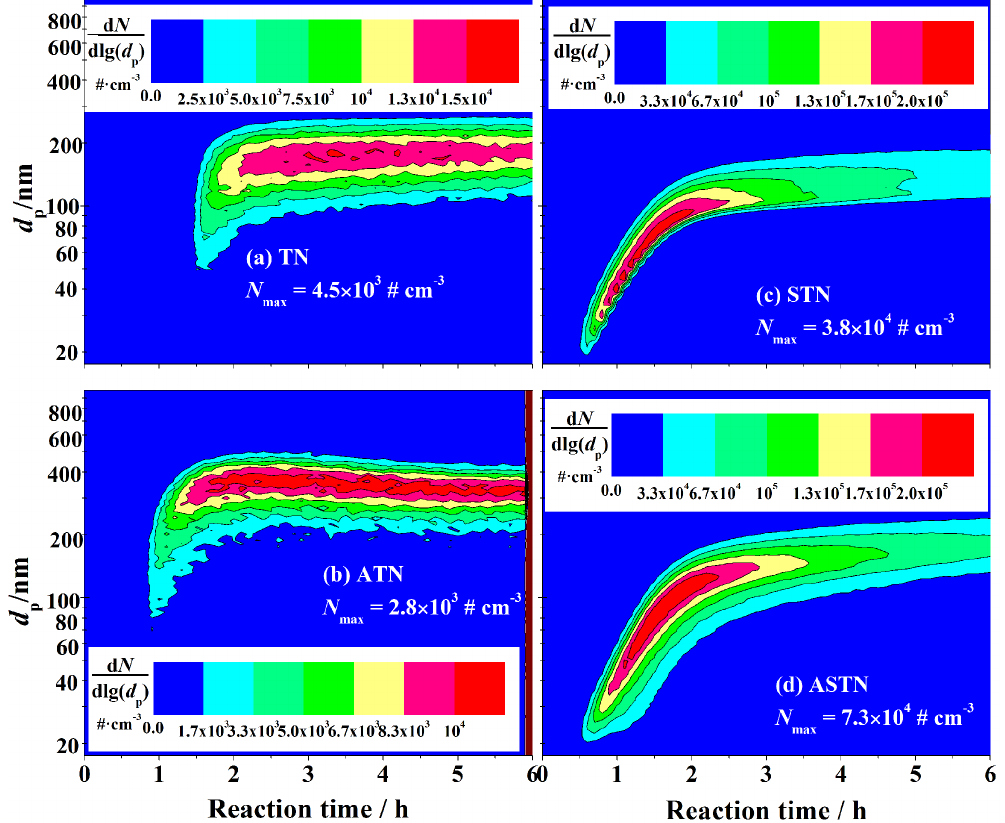
Figure 2. Size distributions of the suspended particles as a function of time during the reaction in photooxidation of toluene / NO x in the presence or absence of NH 3 and/or SO 2 . N max shows the maximal particle number concentration during the reaction for each experiment. Experimental details are listed in Table